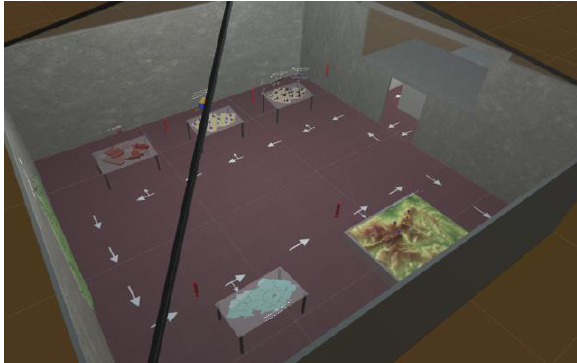
Figure 4. Overview of Carthoreality map room. It is displayed in Unity engine.